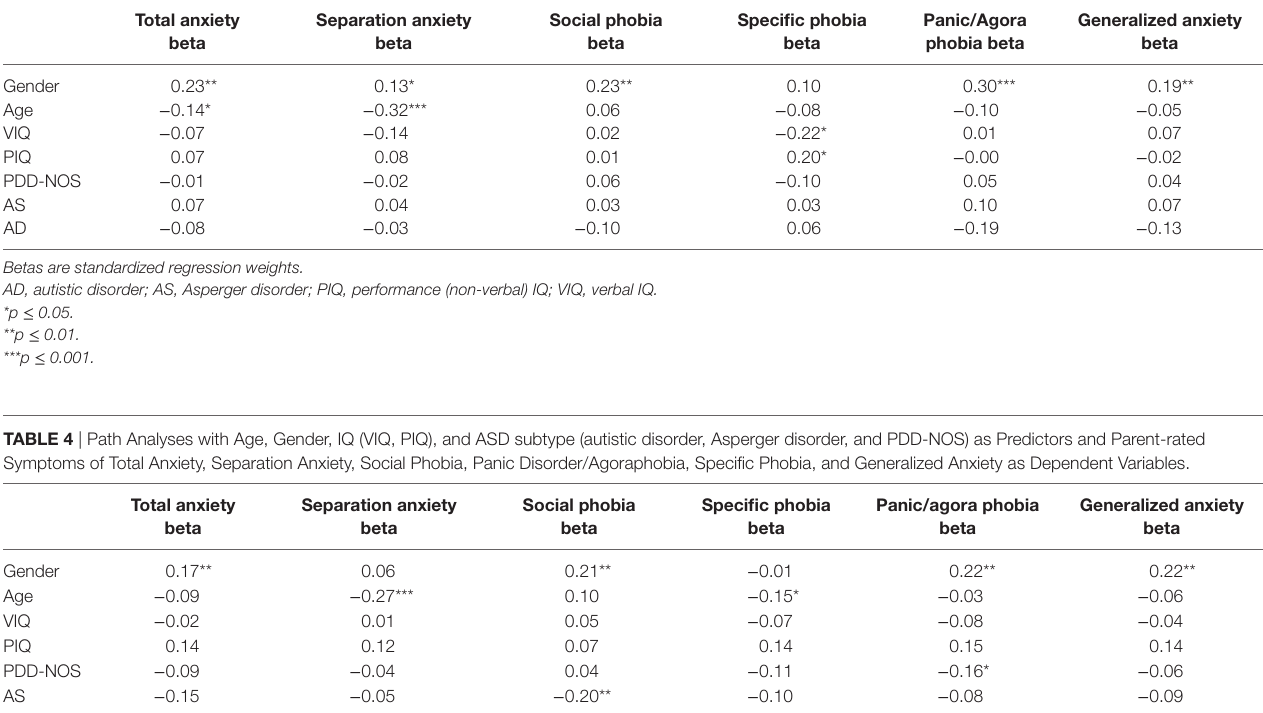
Table 3 | Path Analyses with Age, Gender, IQ (VIQ, PIQ), and ASD subtype (autistic disorder, Asperger disorder, and PDD-NOS) as Predictors and Child-rated Symptoms of Total Anxiety, Separation Anxiety, Social Phobia, Panic Disorder/Agoraphobia, specific phobia, and Generalized Anxiety as Dependent